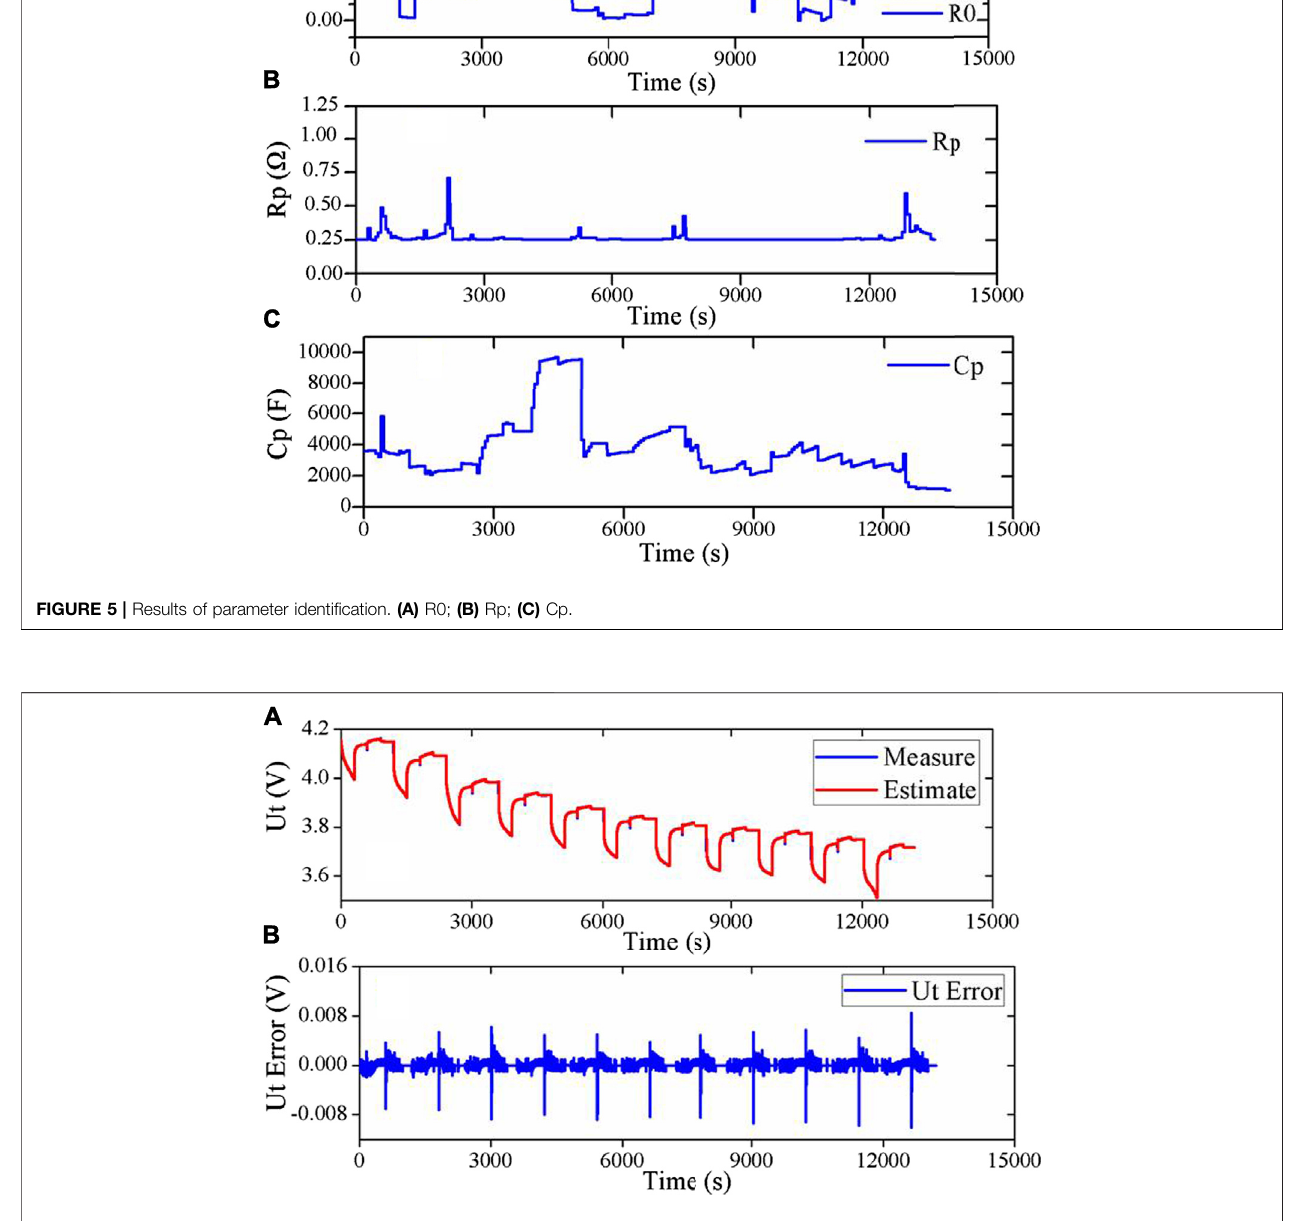
FIGURE 6 | Estimated terminal voltage and error. (A) Comparison of the estimated Ut and measured one; (B) Ut error.